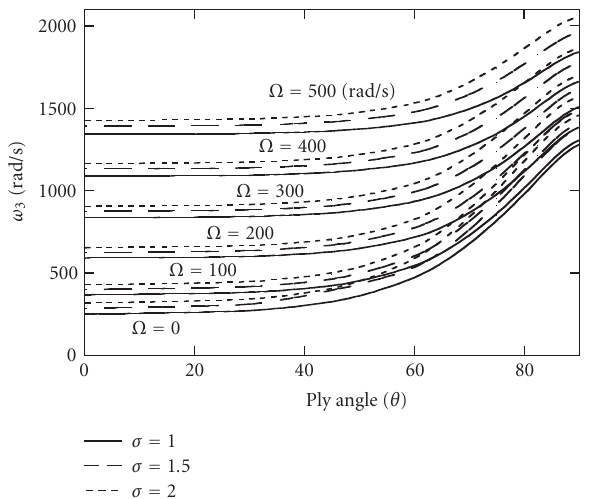
Figure 8: Variation of the second coupled frequency versus pretwisted angle for selected rotational speeds and two di ff erent ta- per ratios ( θ = 90